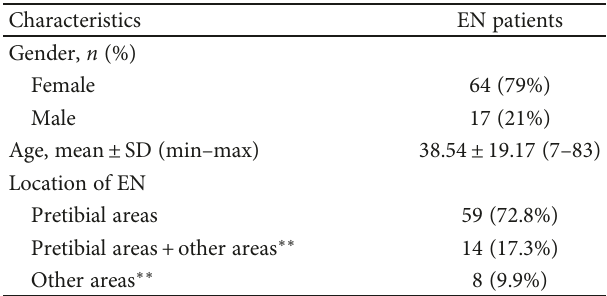
Table 1: Demographic and clinical characteristics of the study subjects ( n = 81